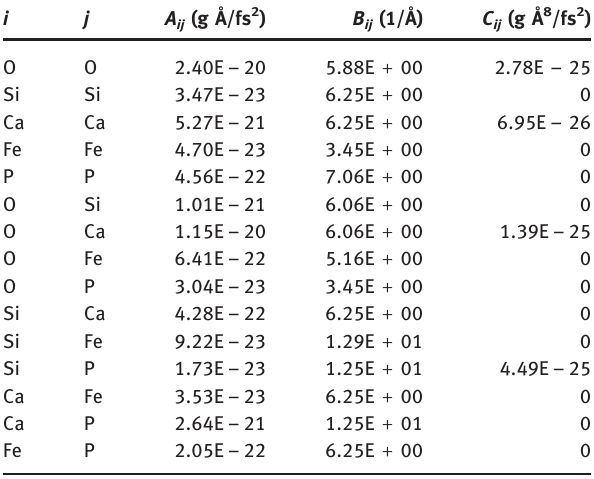
Table 1: Potential parameters used in the MD